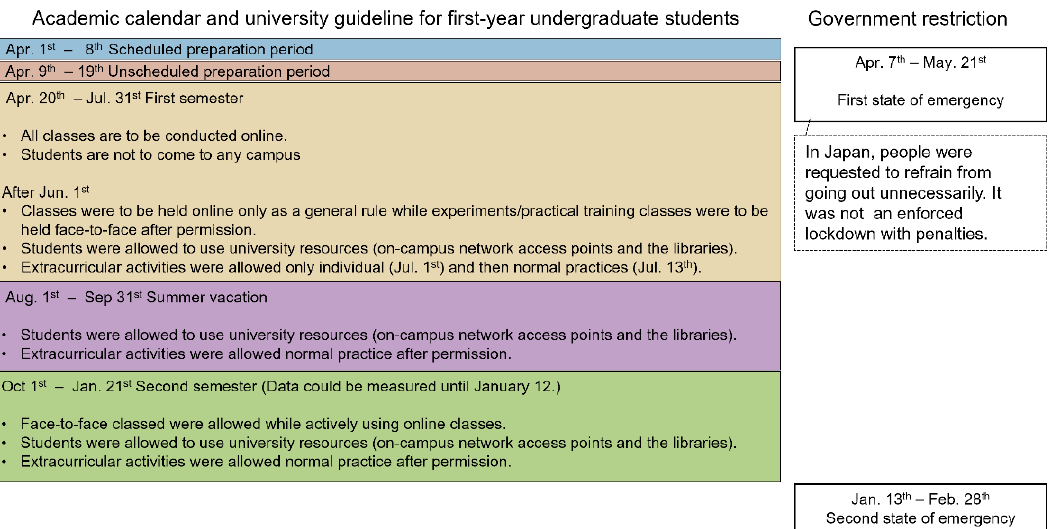
Figure 1. Summary of academic calendar with university guidelines for undergraduate students and Japanese government restrictions [34].